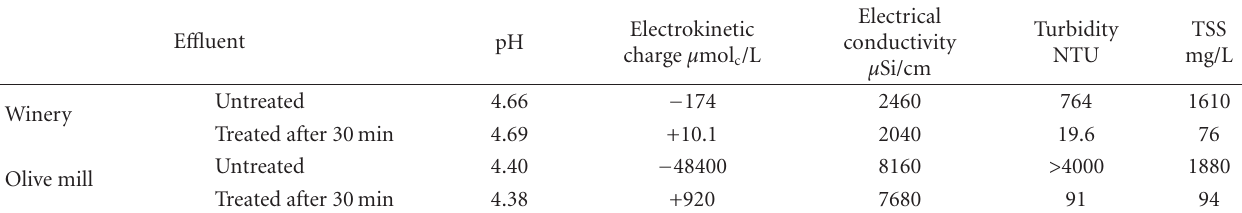
Figure 5: Winery e ffl uents upon addition of 0.1% poly-DADMAC/sepiolite nanocomposite, (a) at the time of addition, (b) 45s after addition, and (c) 90 s after addition. In all panels, the bottle on the left contains untreated e ffl uents. Table 1: Physicochemical parameters of e ffl uents upon addition of 0.05% of a suitable